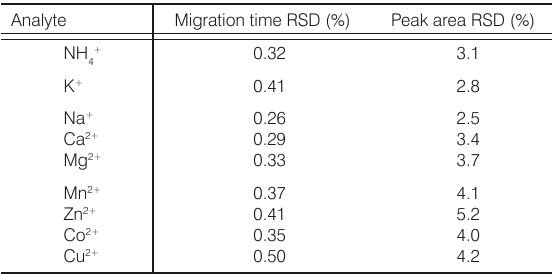
Table 3. Results of coconut milk and jasmine tea drink using CE and AA (mg L -1 ).